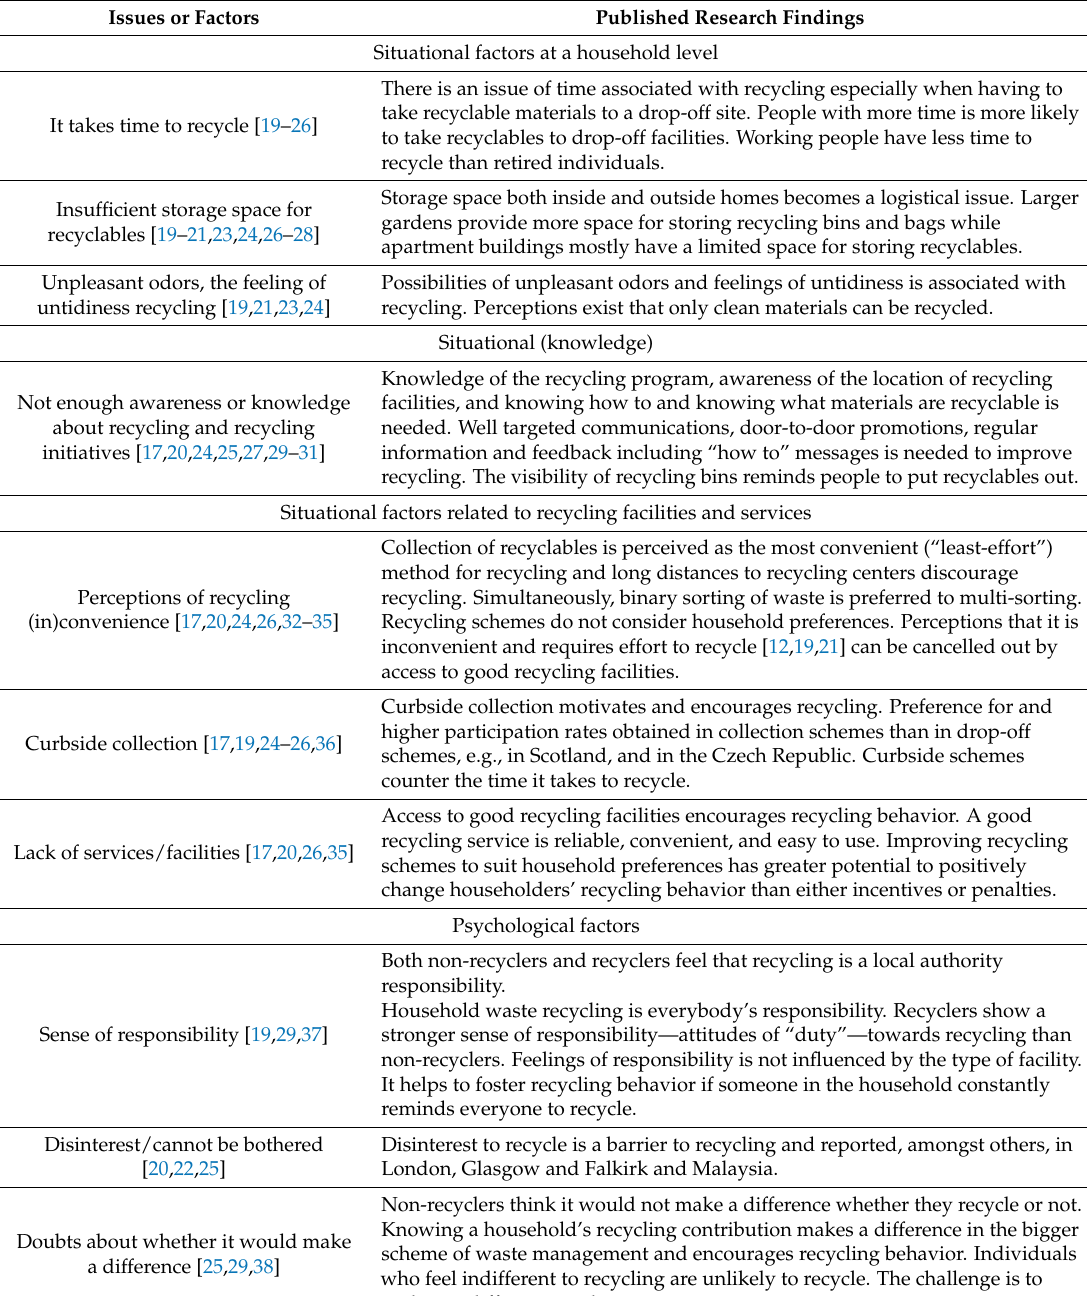
Table 1. Variables or factors affecting recycling